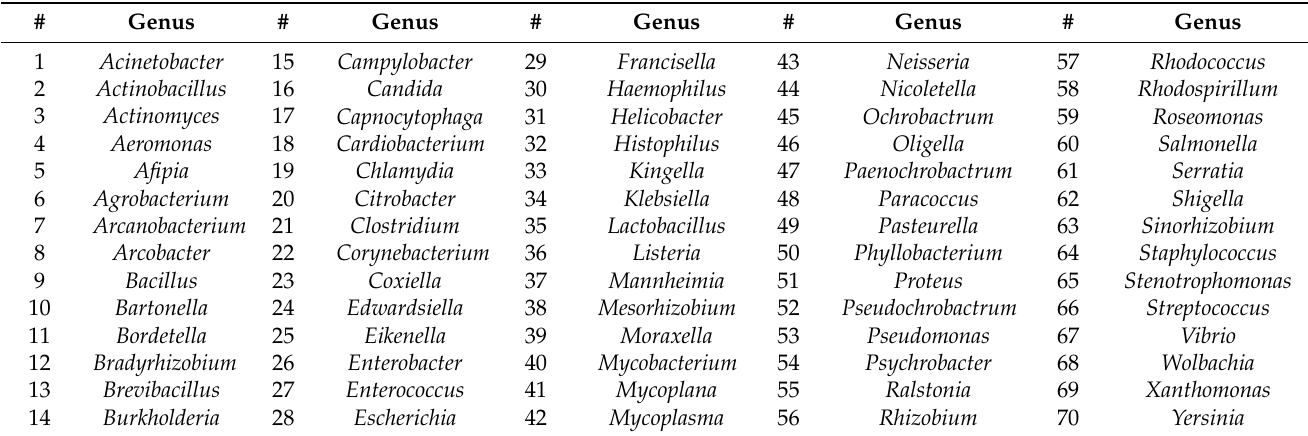
Table 2. Bacterial genera used for specificity test in the reviewed